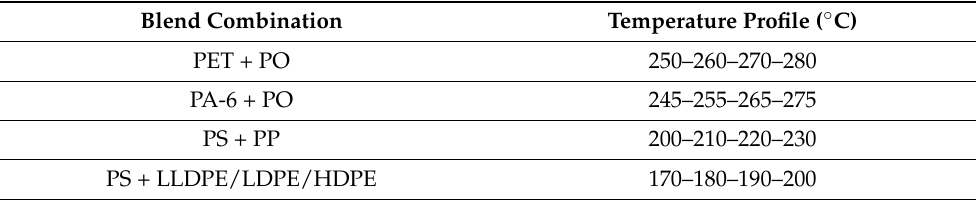
Table 2. Used temperature profiles in injection